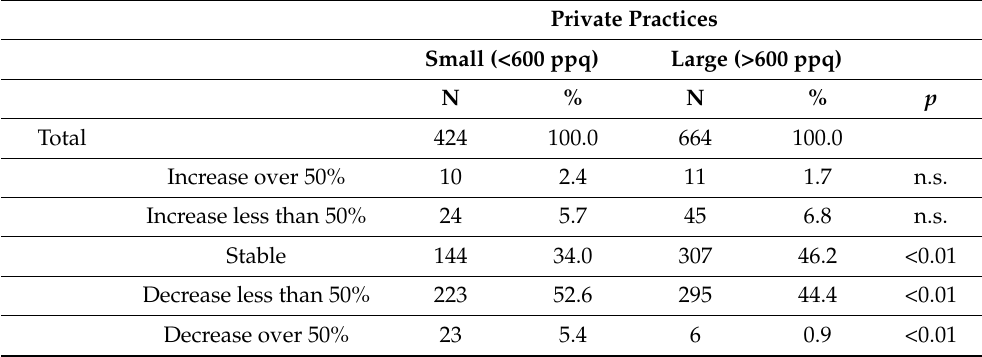
Table 7. Development of